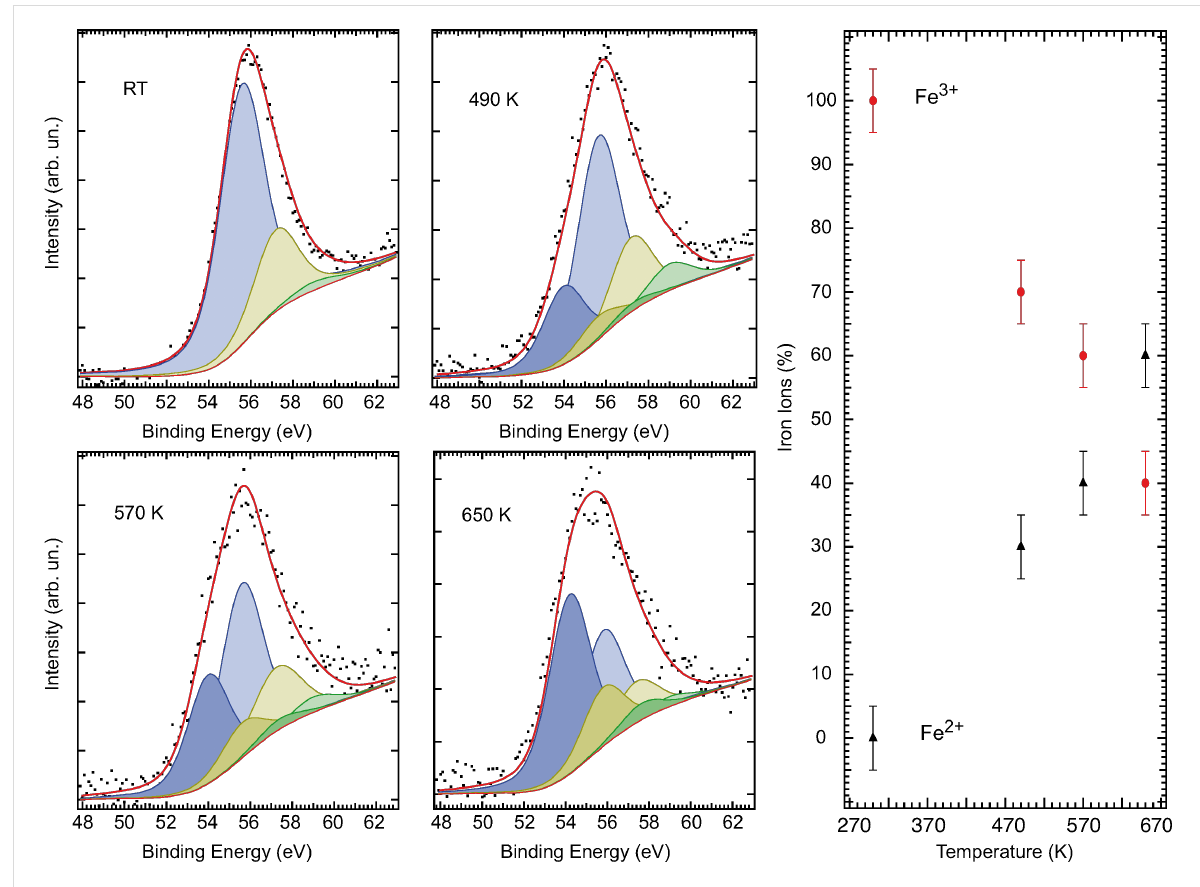
Figure 4: XPS of the Fe 3p core levels as a function of the annealing temperature. Left panels: XPS rough data (black dots), total fitting curves (red continuous lines), along with the deconvolution with contributions associated to the Fe 3+ (light color curves) and Fe 2+ (darker color curves) manifold components. Right panel: relative intensity estimations of the Fe 3+ (red dots) and Fe 2+ (black triangles) content in the NWs as a function of the temperature, as obtained from the fitting of the XPS experimental data (see